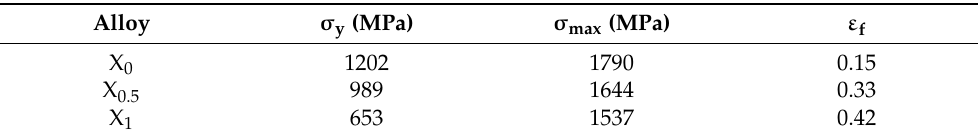
Table 8. Yield stress ( σ y ), compressive stress ( σ max ), and fracture strain ( ε f ) of the X 0 , X 0.5 , and X 1 as-cast